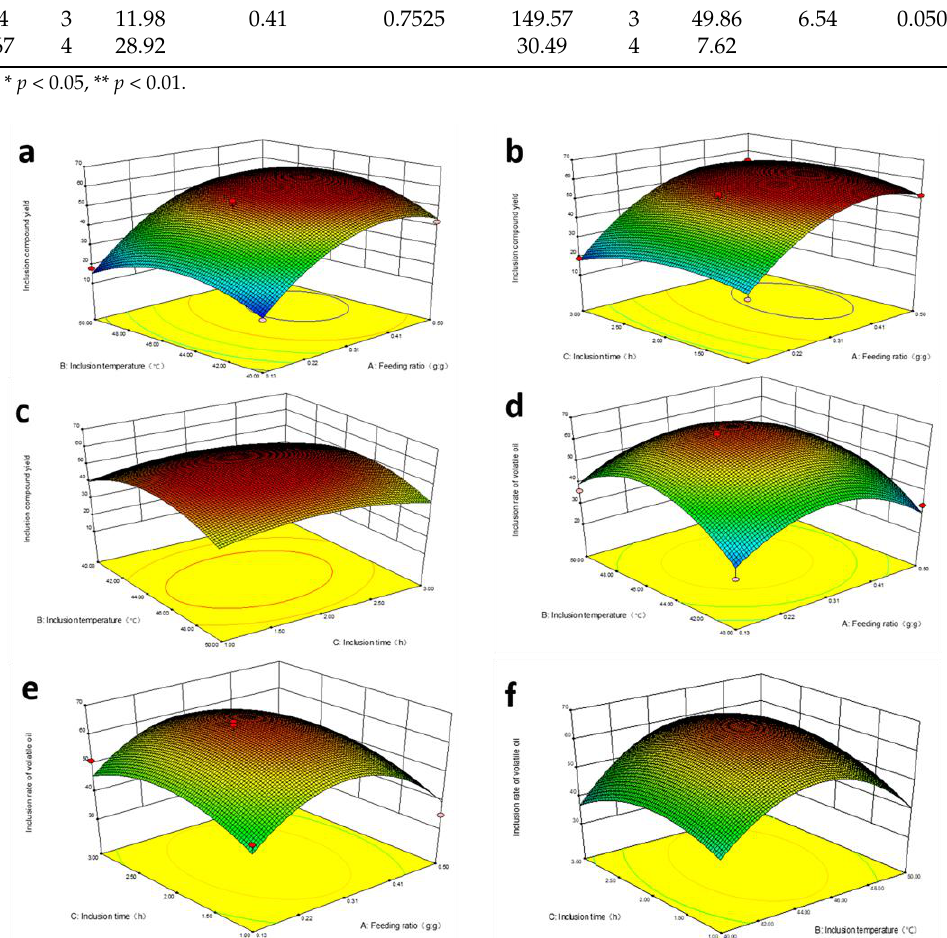
Figure 2. Response surface curve (the 3D plots) showing the relationship between the feeding ratio (g:g), inclusion temperature (°C), and inclusion time (h) toward the response of: ( a ) ICY (%) and ( b ) IEO (%). ( a ) The influence of varying the feeding ratio and inclusion temperature on ICY (%); ( b ) the influence of varying the feeding ratio and inclusion time on ICY (%); ( c ) the influence of varying the inclusion temperature and inclusion time on ICY (%); ( d ) the influence of varying the feeding ratio and inclusion temperature on IEO (%); ( e ) the influence of varying the feeding ratio and inclusion time on IEO (%); ( f ) the influence of varying the inclusion temperature and inclusion time on IEO (%).